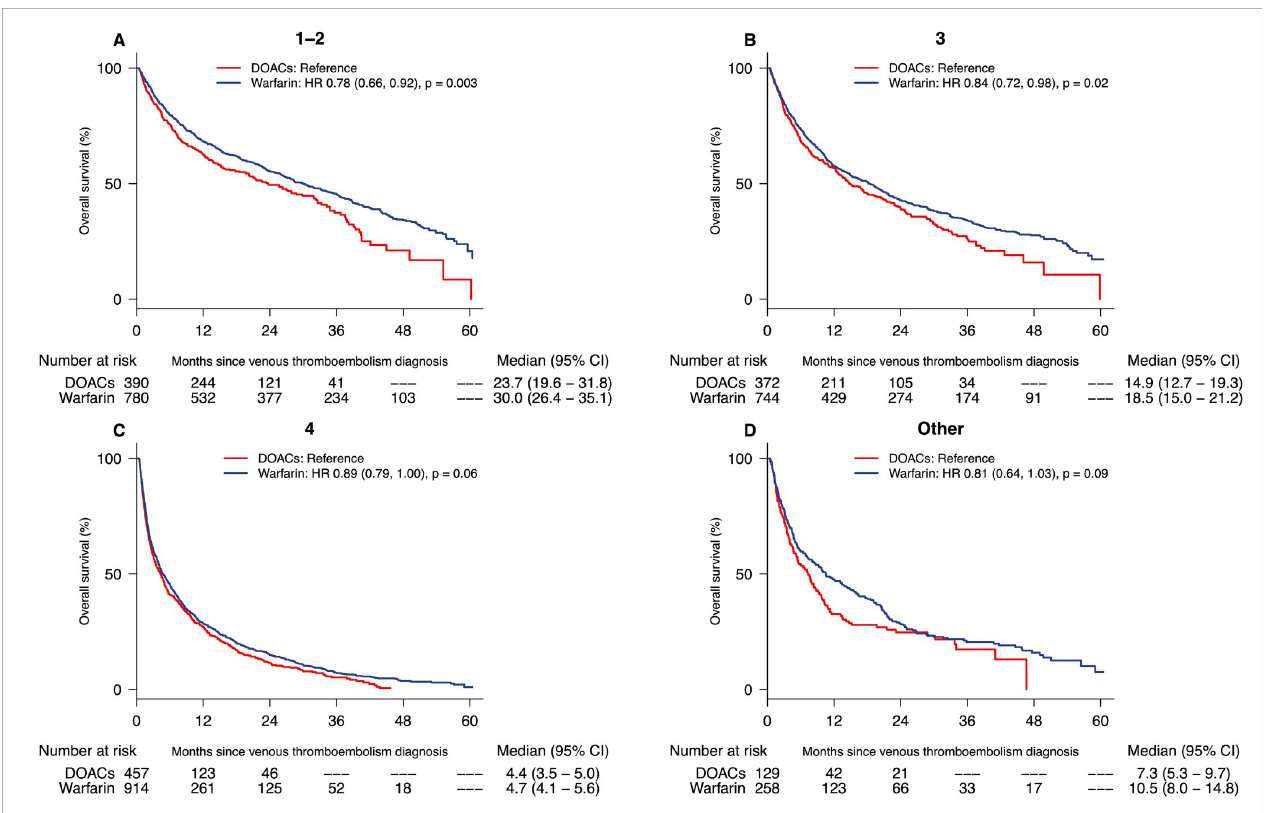
Fig 2. Kaplan–Meier estimate of overall survival with DOAC-treated patients (red line) compared to warfarin (blue line) in all cancers with stages 1 to 2 (panel A), stage 3 (panel B), stage 4 (panel C), and stage not applicable and unknown (panel D). CI, confidence interval; DOAC, direct oral anticoagulant; HR, hazard